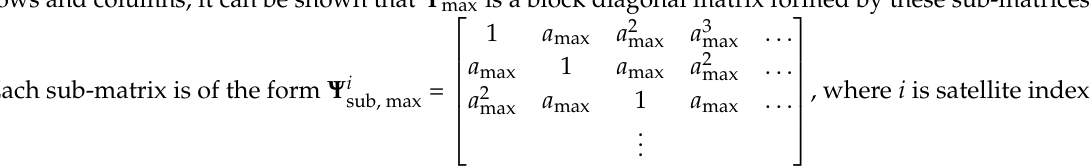
Figure 2. Variation of upper and lower bounds of exp ( − β ∆ t ) × elevation angles at epoch (cid:96) , and ∆ t = 1